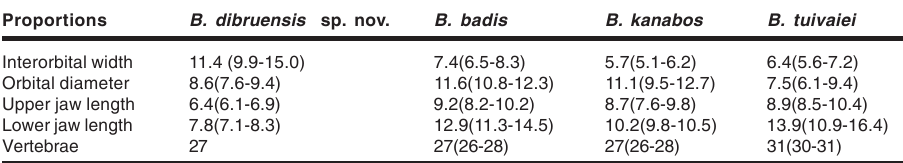
Table 4. Comparison of proportional measurements in percentage of standard length and counts of Badis dibruensis sp. nov. with related species in mean and (range in parentheses).